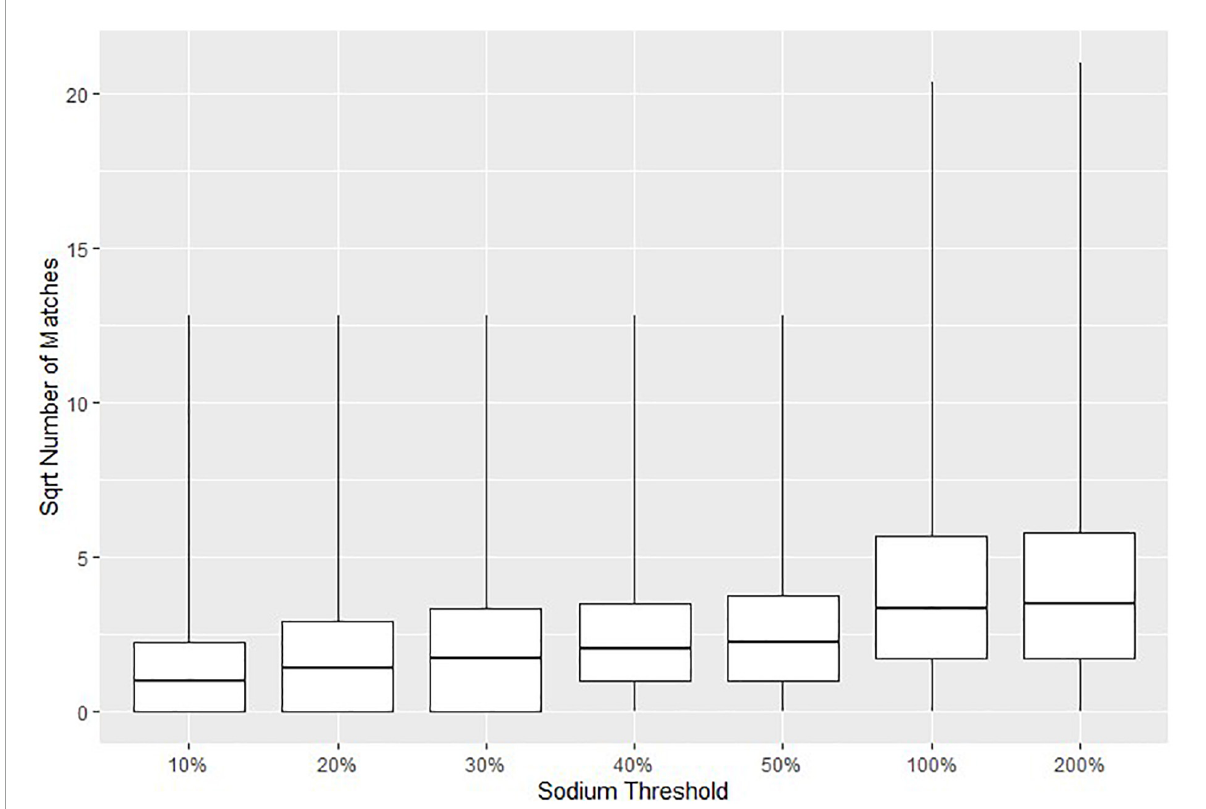
FIGURE3 Boxplots indicating the 0th, 25th, 50th, 75th, and 100th percentiles of the square roots of the numbers of Canadian Nutrient File (CNF) suggested matches for all Euromonitor products as a function of the threshold selection for sodium. The threshold for carbohydrate, protein, and fats was set to 20% and the threshold for fiber, saturated fat, and sugar was set to 10% in all cases. Fuzzy string matching was not used. The square root number of matches is reported due to the large numbers of matches when using higher